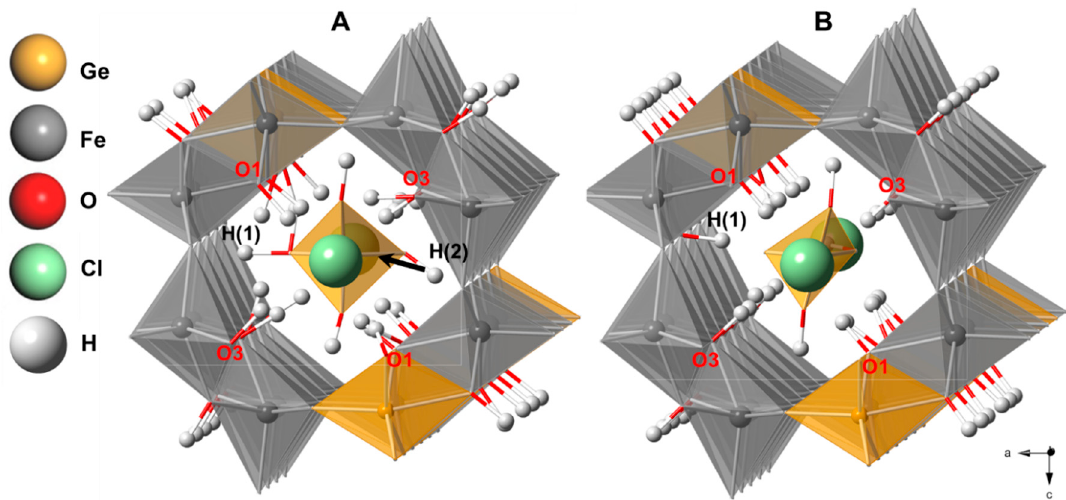
Figure 3. ( A ) A view of the hypothetical Ge ‐ akaganéite model II applied to DFT ‐ D calculation. ( B ) A view of the optimized Ge ‐ akaganéite model II. H (1) hydrogen is bound to the oxygen of octahedral framework, and the Ge ‐ tetrahedra exists as GeO(OH) 3 − .